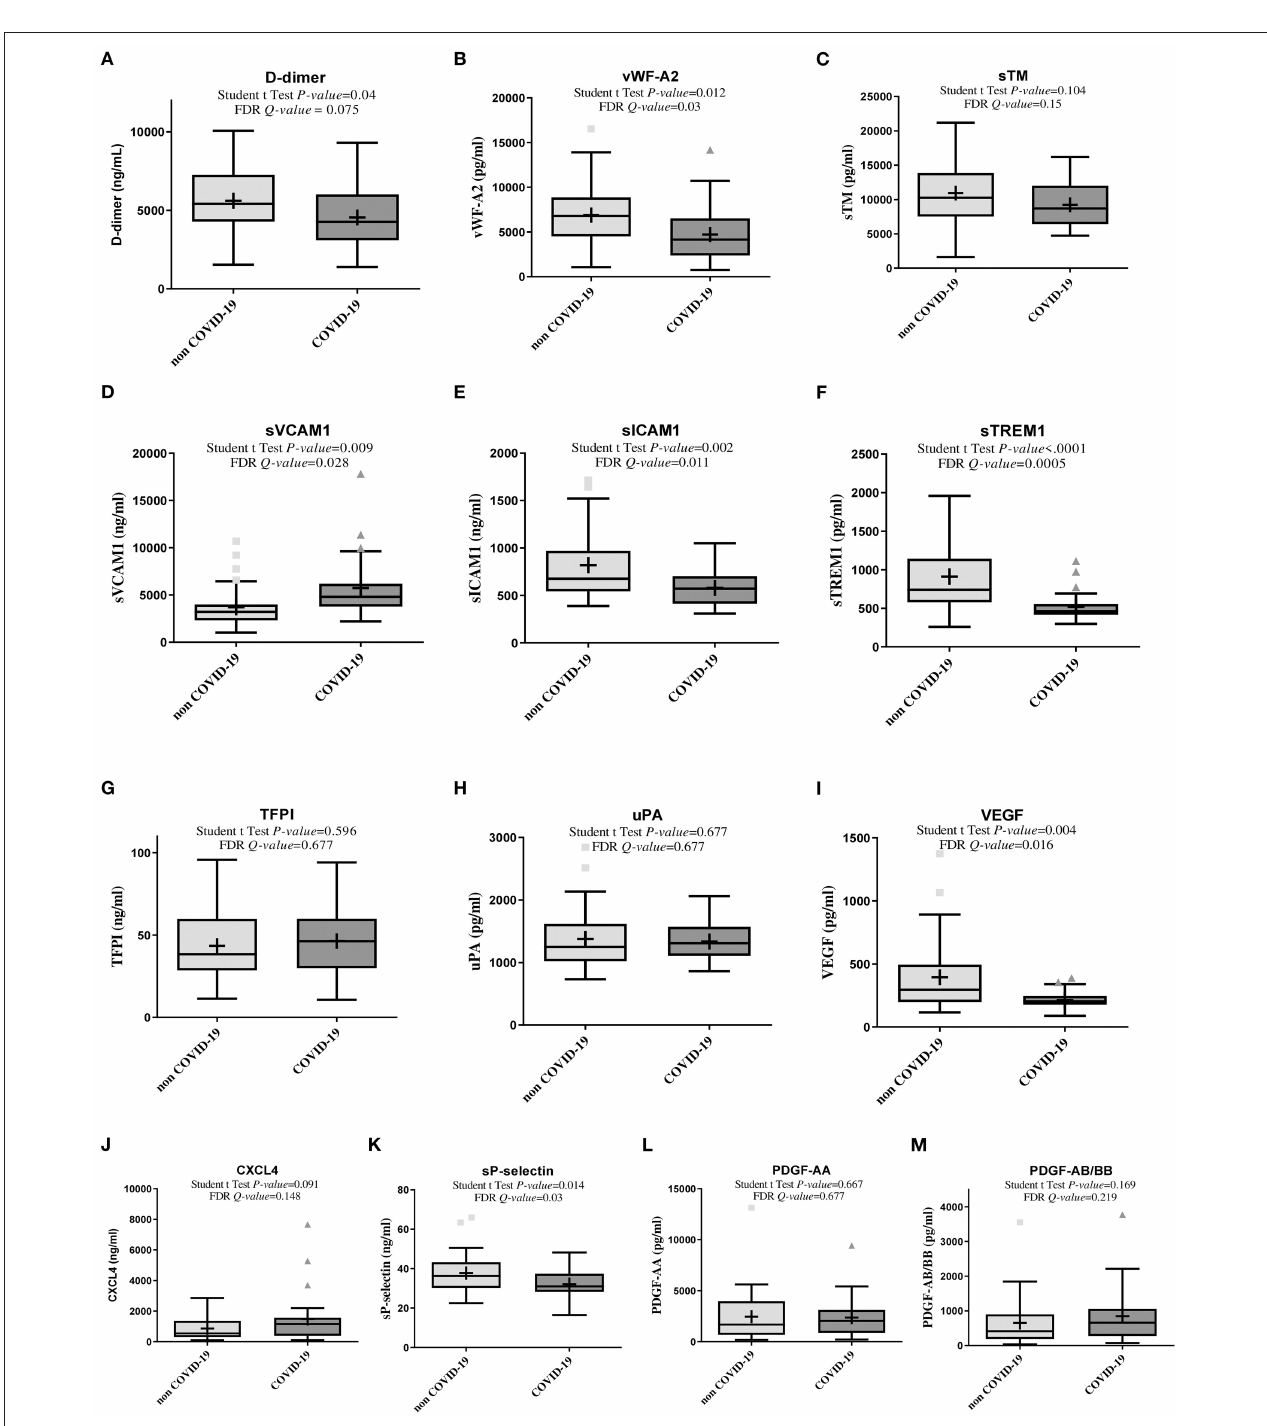
FIGURE 1 | Box plot showing plasma concentrations of biomarkers of coagulopathy in non-COVID-19 and COVID-19 patients (Lymphonie study 2018–2020). Plasma concentration of biomarkers of coagulation and/or endothelium and platelet activation was measured within 48 hours of hospitalization in 36 non-COVID-19 and 27 COVID-19 patients with severe pneumonia. COVID-19 patients had significantly higher plasma concentrations of sVCAM1 (D) , lower plasma concentration of D-dimers, vWF-A2, sICAM1, sTREM1, VEGF, sP-selectin (A,B,E,F,I,K) and a non-significant difference for plasma levels of sTM, TFPI, uPA, CXCL4, PDGF-AA and PDGF-AB/BB. For each cytokine, P -values from Student t test and Q -value of the false discovery rate (FDR) are indicated. COVID-19, coronavirus disease 2019; CXCL4, platelet C-X-C motif chemokine ligand 4; FDR, false discovery rate; PDGF, platelet derived growth factor; sICAM-1, soluble intercellular adhesion molecule 1; sTREM-1, soluble triggering receptor expressed on myeloid cells 1; sVCAM-1, soluble vascular cell adhesion molecule 1; sTM, soluble thrombomodulin; TFPI, tissue factor pathway inhibitor; uPA, u-plasminogen activator; VEGF, vascular endothelial growth factor; vWF-A2, von Willebrand factor A2 (LYMPHONIE study, 2018–2020).